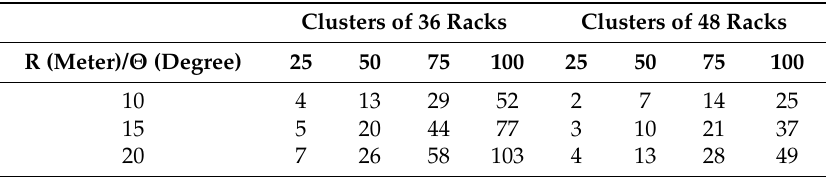
Table 2. The number of direct inter-rack links one FSO node can establish.